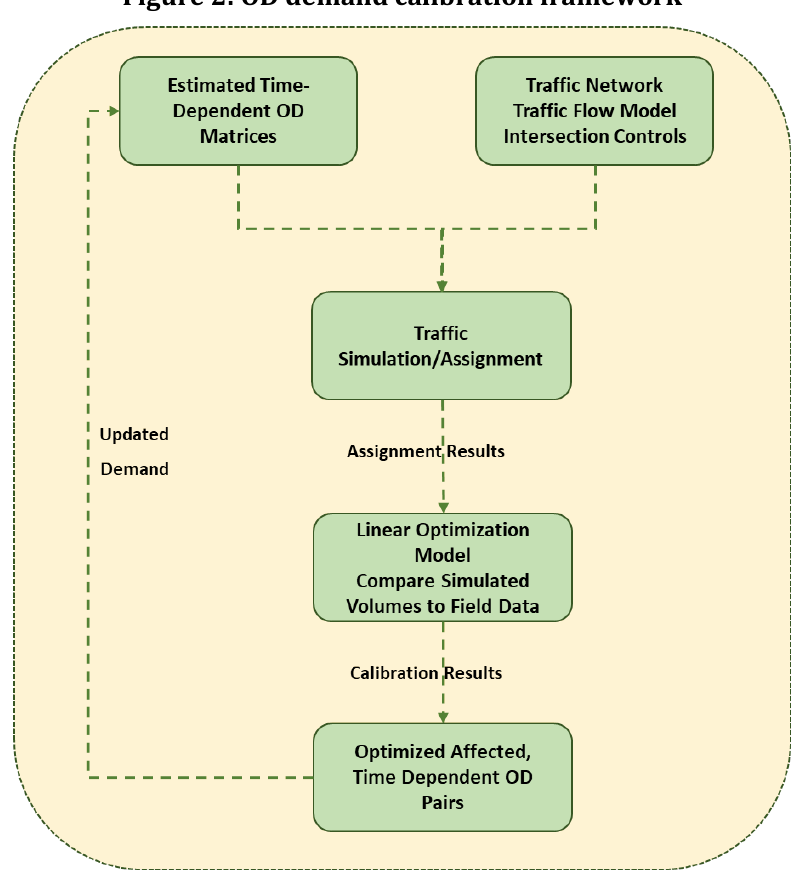
Figure 2: OD demand calibration framework